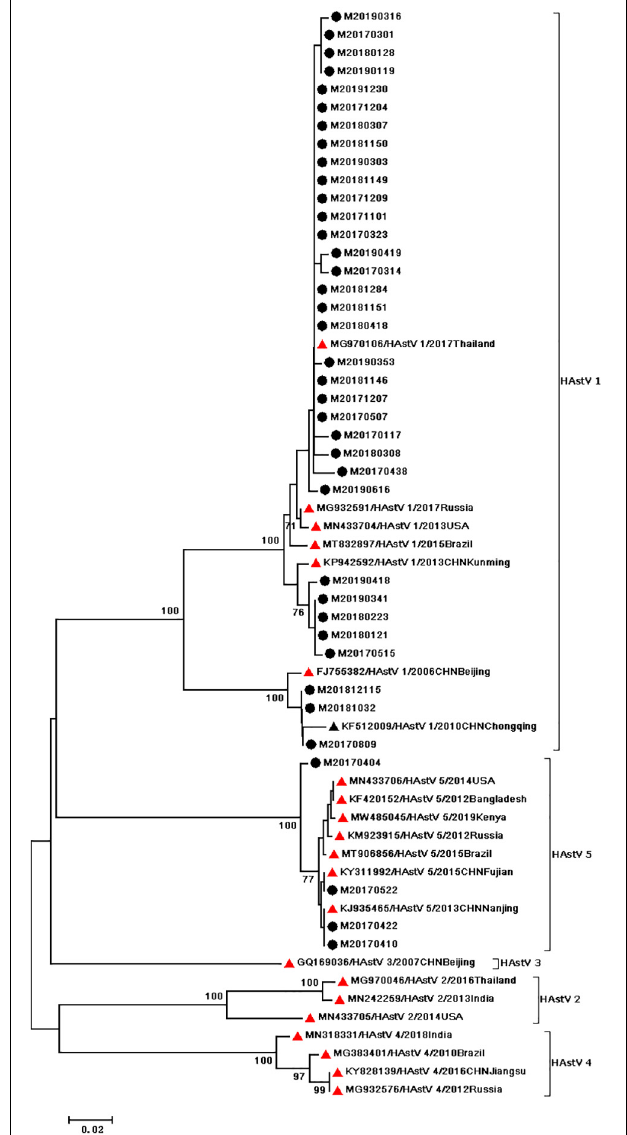
FIGURE 3 | Phylogenetic tree of HAstV detected in Chongqing based on the 449bp-partial capsid (ORF2) sequence. The dendrogram was constructed by the maximum likelihood method with the Kimura two–parameter model in MEGA 7.0. Numbers at each node represents bootstrap values obtained with 1,000 replicates ( > 70 are shown). The scale bar represents the unit for the expected number of substitutions per site. Strains from the present (designed M/year/month/number) and previous(including accession number, genotype, year, and location) study are labeled with a black circle and black triangles. Red triangles indicate reference strains (including accession number, genotype, year, and location). work will be required to establish the association in